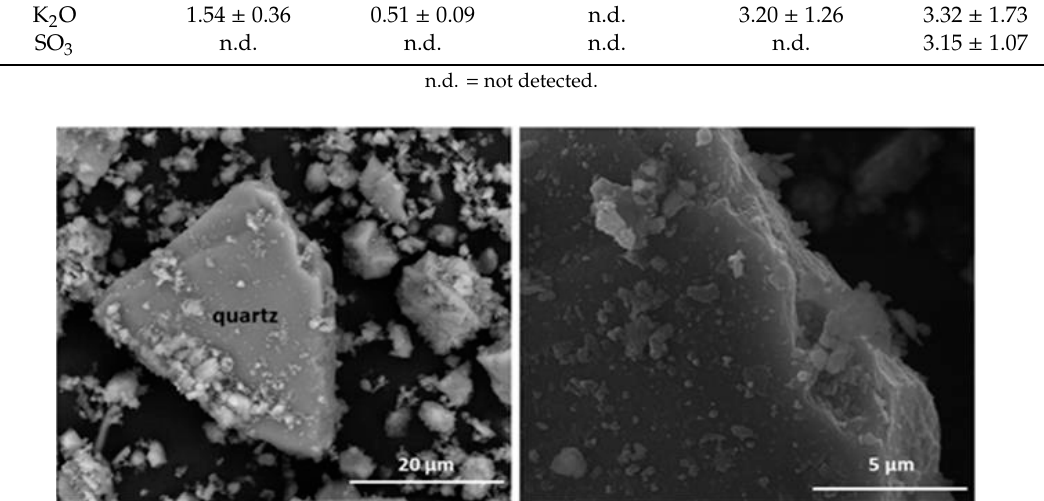
Figure 5. ( left ) Quartz and surface deposits. ( right ) Detail of deposits on initial HsC waste.